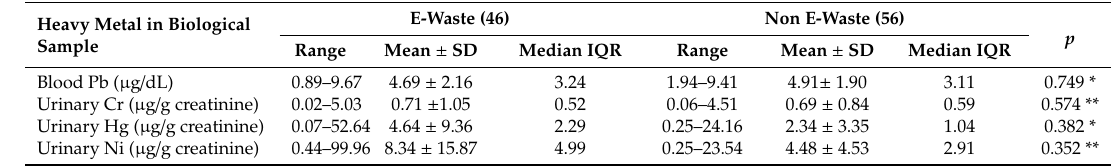
Table 6. Average concentrations of blood lead (Pb) and urinary mercury (Hg), nickel (Ni), and chromium (Cr) in study subjects stratified by involvement in electronic waste (e-waste) activities.